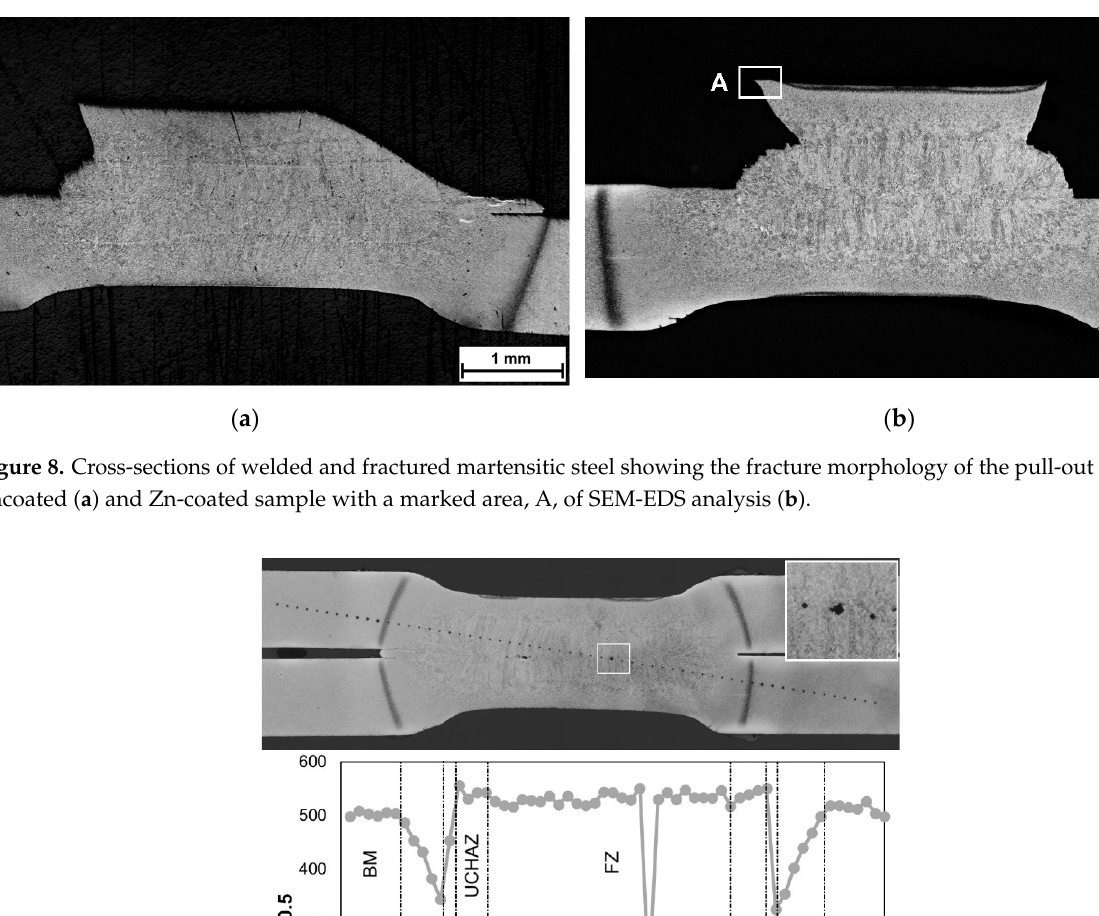
10 of 14 Table 6. Results from the comparison of coated and uncoated samples examined by tensile shear tests (tensile shear strength—TSS, partial thickness fracture—PTF, button pull ‐ out—BP, button pull ‐ out fracture—PF, interfacial fracture—IF). Samples